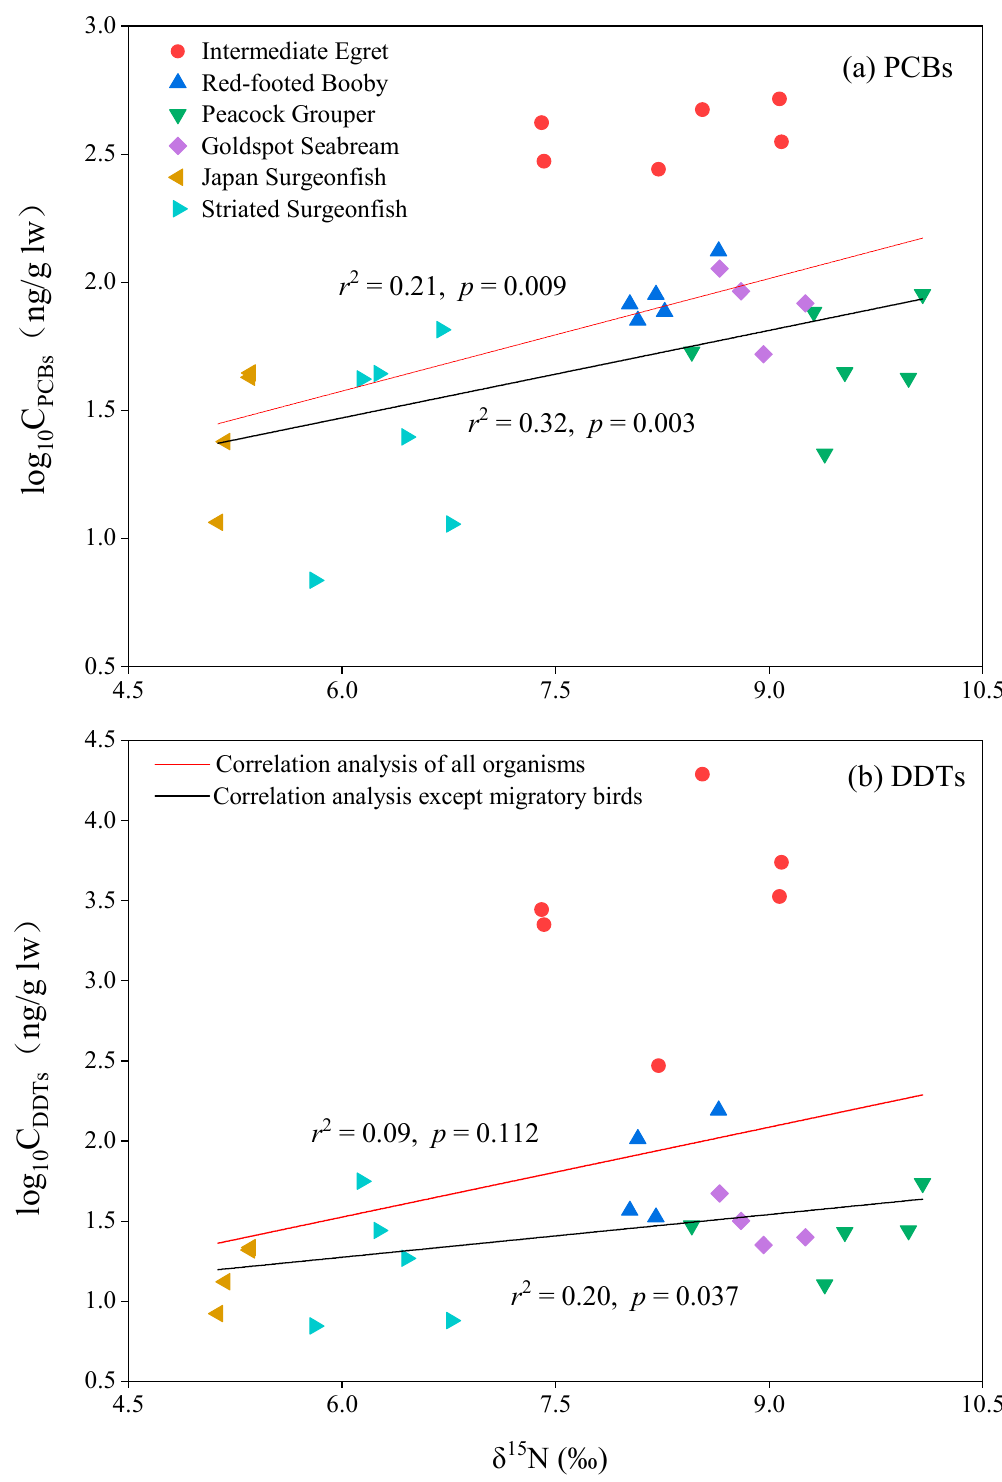
Figure 4. Relationships between concentrations of PCBs and DDTs and δ 15 N in biota species from Qilianyu Island.